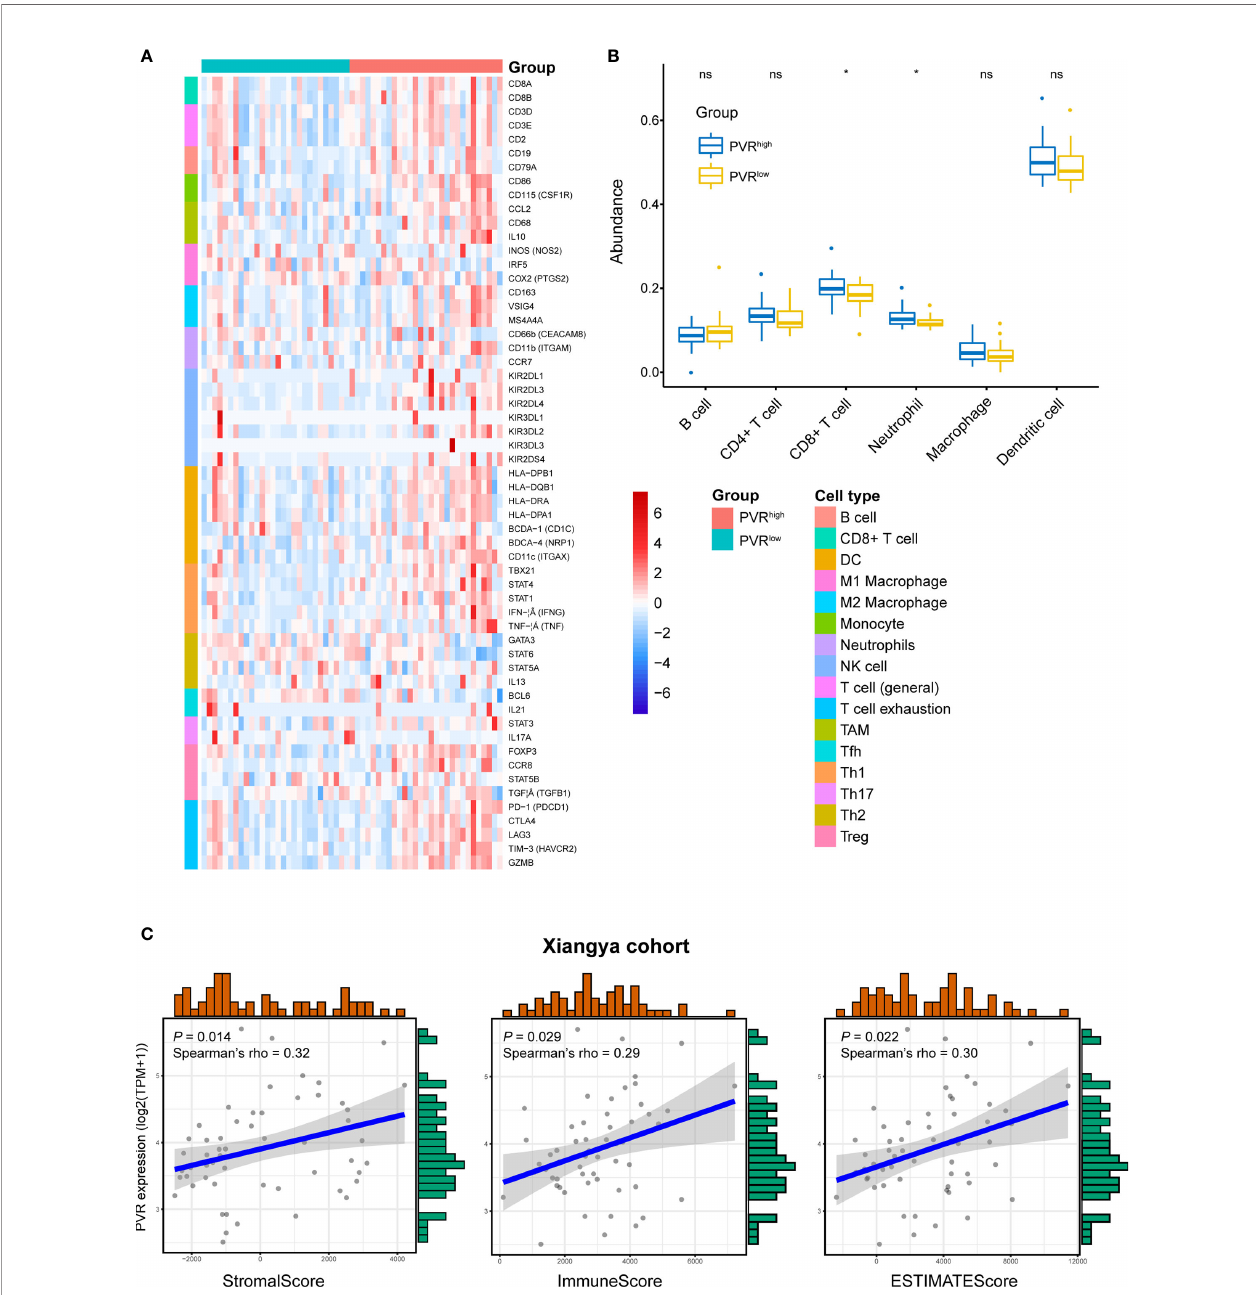
FIGURE 4 | Validation of PVR ’ s role in tumor purity and immune in fi ltration using Xiangya cohort. (A) The heatmap of markers on multiple immune in fi ltrates. (DC, dendritic cell; NK cell, natural killer cell; TAM, tumor associated macrophages; Tfh, follicular helper T cell; Th1, type 1 helper T cell; Th17, type 17 helper T cell; Th2, type 2 helper T cell; Treg, regulatory T cell) (B) The abundance of 6 immune in fi ltrates between PVR high and PVR low groups in Xiangya cohort (based on TIMER algorithm). (C) PVR expression correlates with stromal, immune, and ESTIMATE scores, respectively in Xiangya cohort. *P < .05. ns, not signi fi